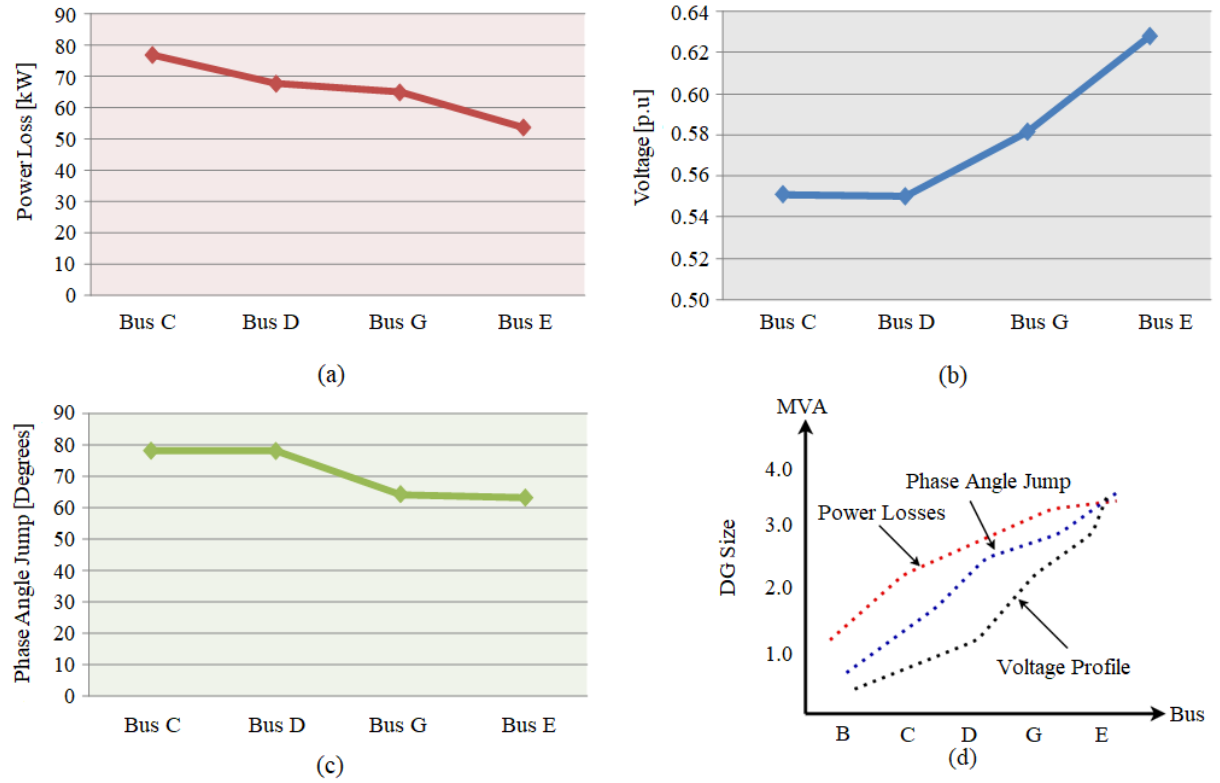
Figure 9. System profile during the islanding condition for the optimal location and size of the new DG: ( a ) power losses at different buses, ( b ) voltage profile of the system, ( c ) PAJ variations at different buses, and ( d ) GA output over 35